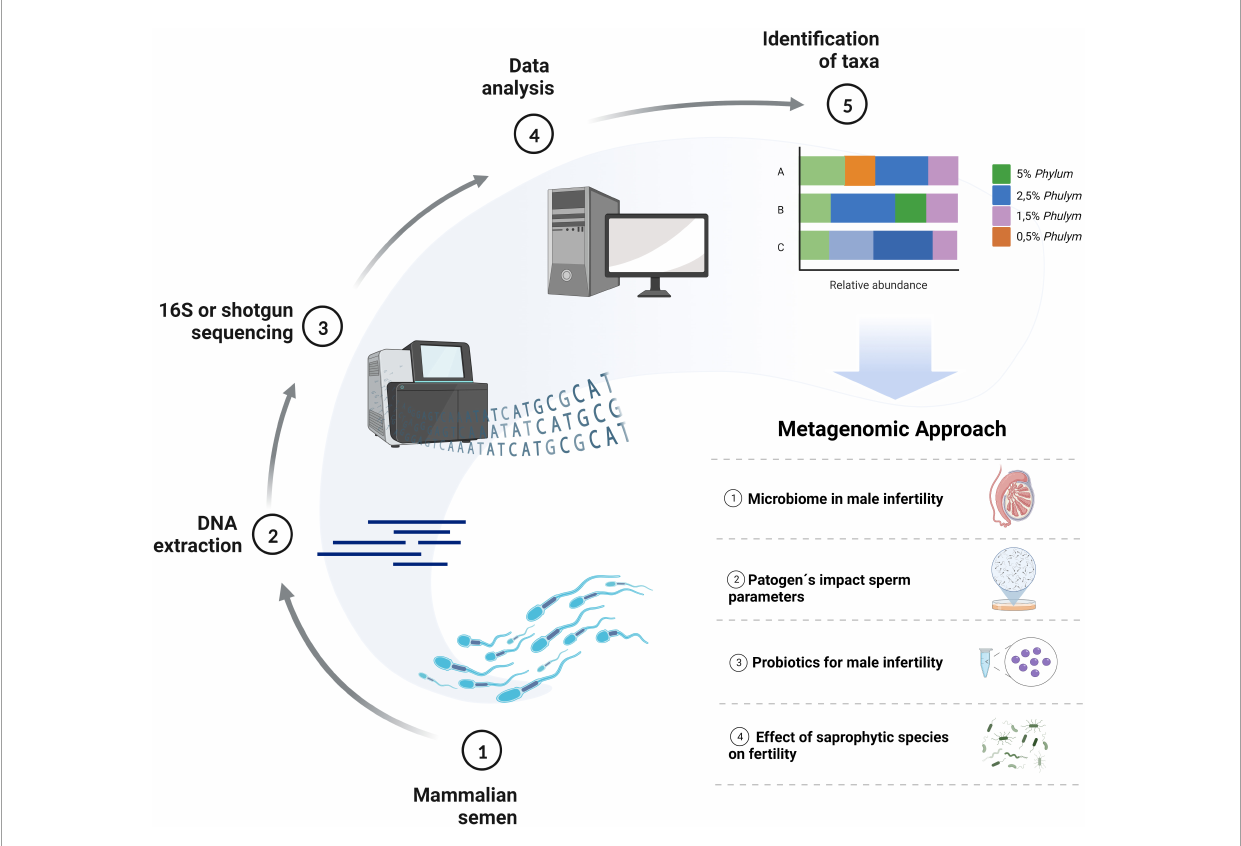
FIGURE1 Metagenomics’ approach to future studies in mammalian reproduction. Diagram describing the experimental design and prospects for using metagenomics and sequencing technologies to develop reproductive knowledge. Created with